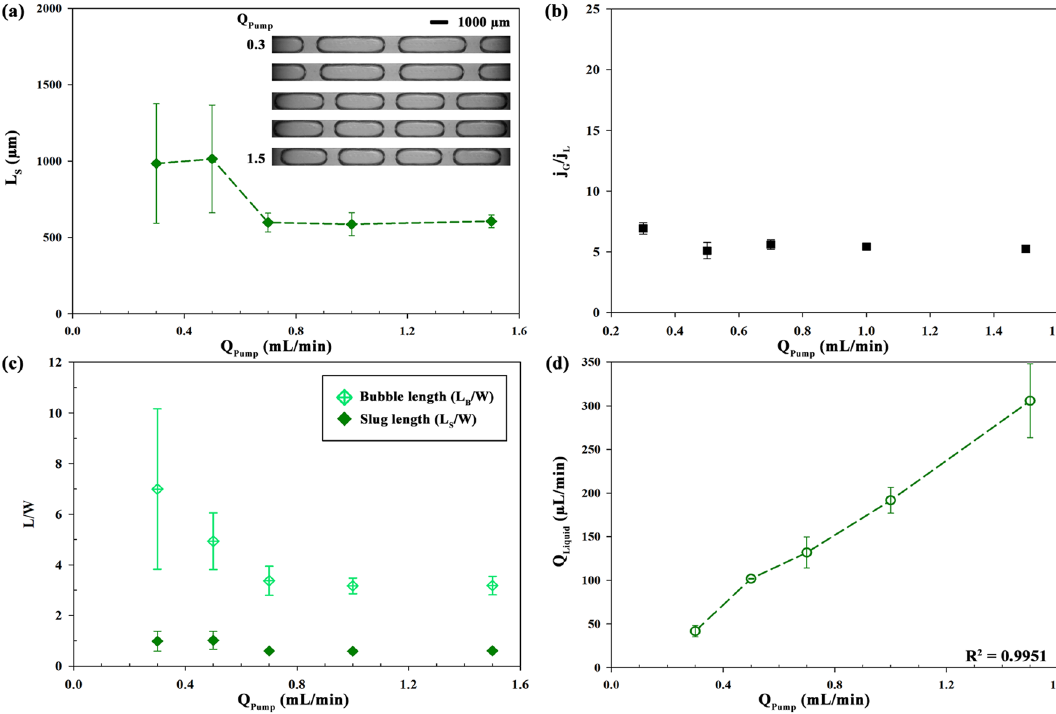
Figure 6. ( a ) Length of slugs ( L S ) depending on pump flow rate [ Q Pump (mL/min)] of the syringe pump and representative images in 3D-printed chip as an inset of plot. ( b ) Air–liquid superficial velocity ratio ( j G / j L ), ( c ) dimensionless length ( L S /W, L B /W) and ( d ) flow rate of slugs ( Q Liquid ) depending on Q Pump . Correlation coefficients between Q Liquid and Q Pump is R 2 = 0.9951 ( Q Liquid